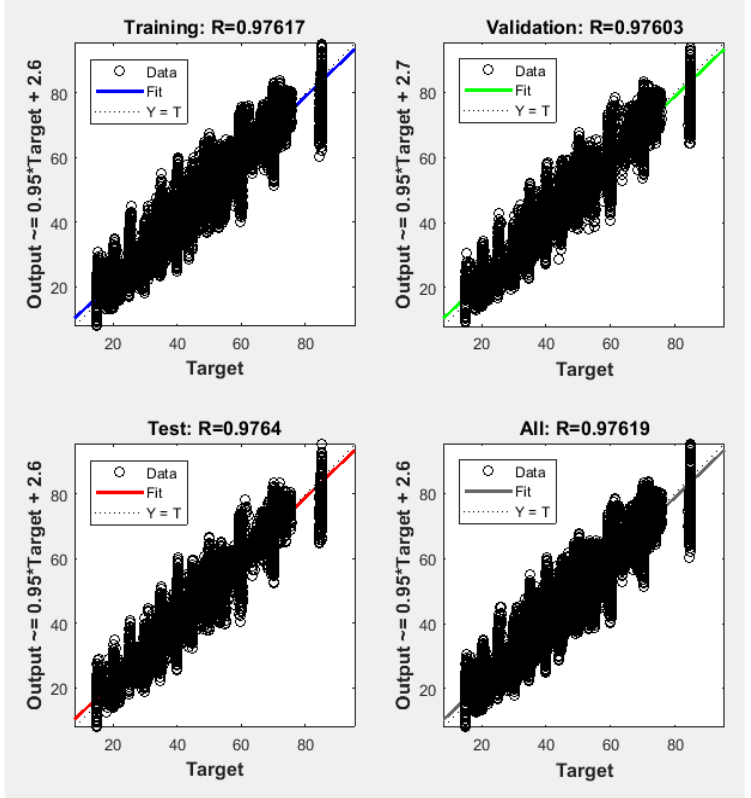
Figure 8. Regression plots of the training, testing, and validation data with the CGF algorithm at 400 neurons in the hidden layer.